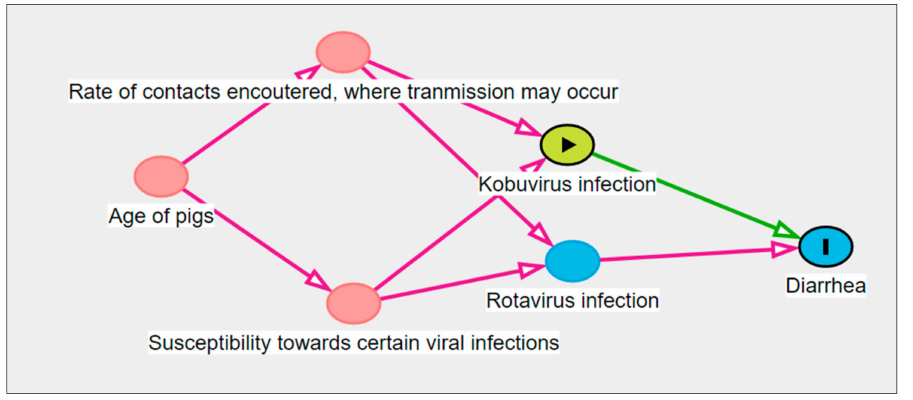
Figure 1. Directed acyclic graph proposing variables possibly confounding the causal effect of porcine kobuvirus on diarrhea incidence in weaned pigs. The figure was created by the author using http://www.dagitty.net/dags.html [63]. Kobuvirus infection may be associated with rotavirus infection (and other viral infections) because they have shared ancestors (i.e., they are both effects of the same cause). In epidemiological studies, this confounding will introduce bias to the estimate of the causal effect of the exposure, kobuvirus infection, on the outcome, diarrhea, if appropriate adjusting is ignored. Using causal inference theory, the minimal set of variables to be adjusted for to identify the causal effect of interest is either susceptibility to certain viral infections and the rate of contacts encountered, where transmission may occur, or Rotavirus infection. The latter will often be the easiest to